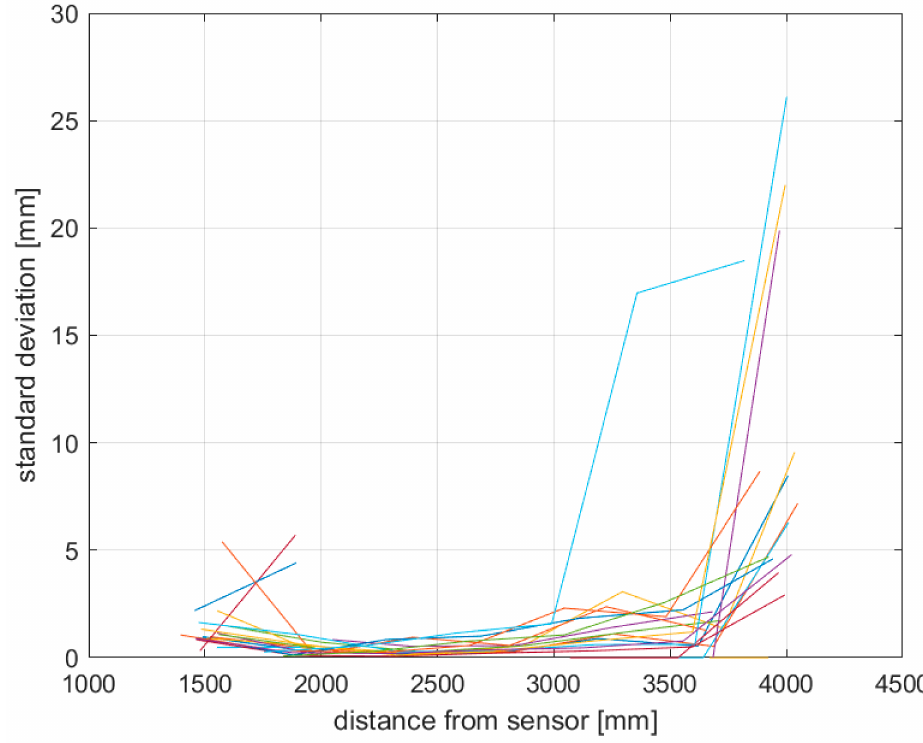
Figure 8. Body joint precision measurements of Kinect v1.